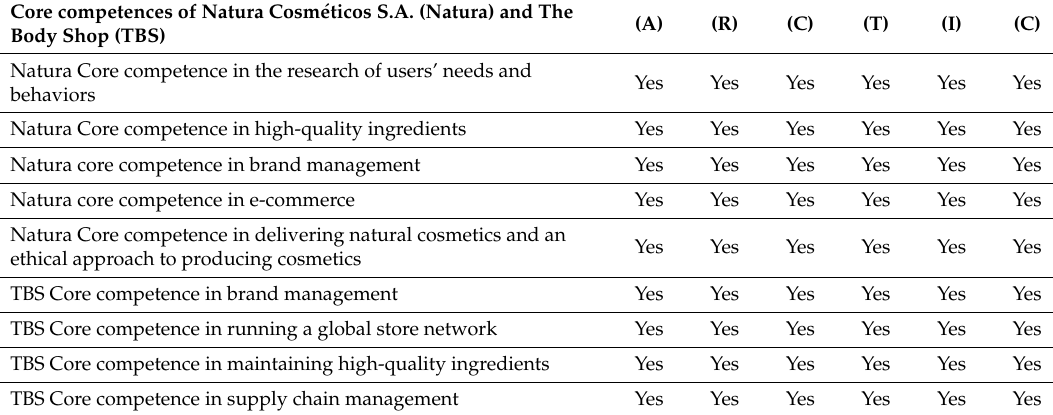
Table 2. ARCTIC framework for the pre-acquisition analysis of competence-based synergies (Natura’s acquisition of The Body